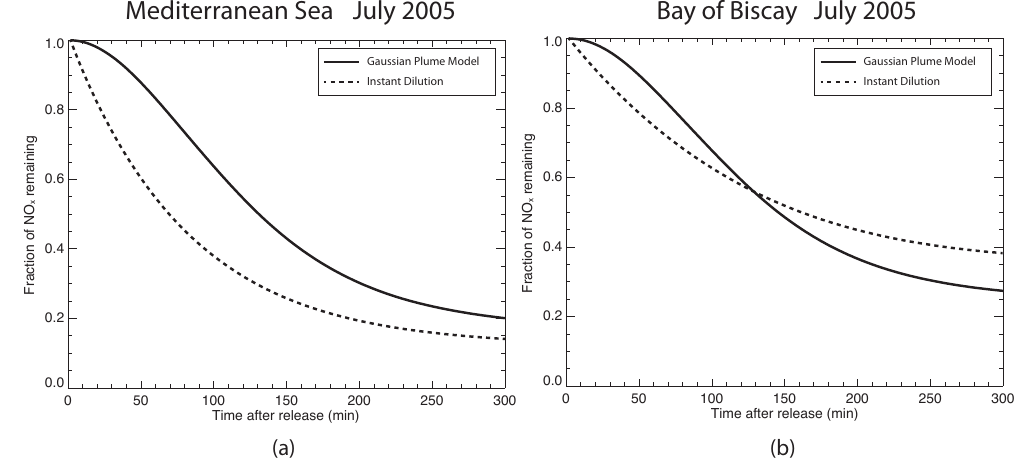
Fig. 2. Fraction of NO x remaining as function of time calculated by the PARANOX Gaussian plume model (Vinken et al., 2011) for two representative cases in the Mediterranean Sea (a) and the Bay of Biscay (b) for July 2005. The solid line indicates the fraction of NO x remaining in an expanding plume with initial size of 5 × 5m 2 , and the dashed line represents an initial plume size of 50 × 50km 2 (approximating instant